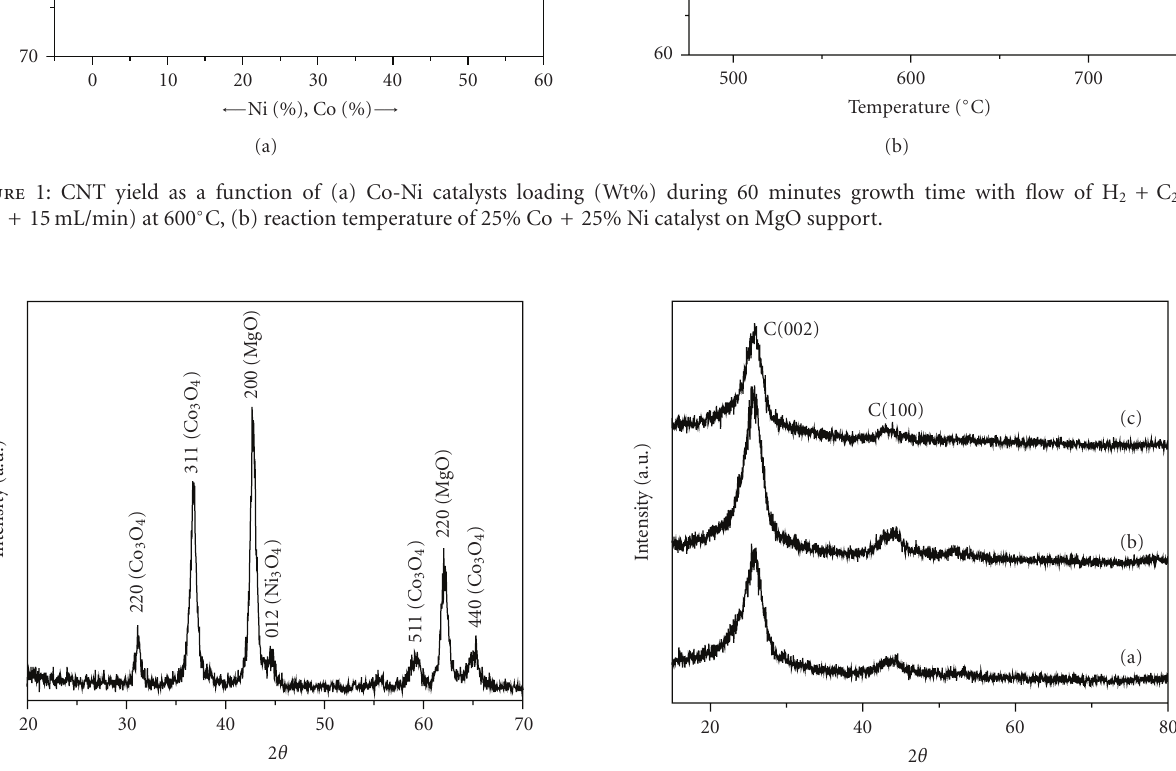
Figure 3: Representative powder XRD patterns for CNTs synthe- sized using (a) 50% Co, (b) 25% Co + 25% Ni, and (c) 50% Ni on MgO